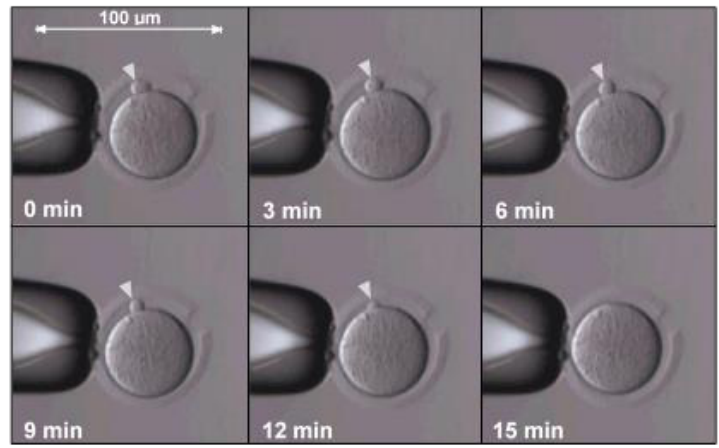
Figure 4. Time-lapse images showing fusion of a cumulus cell into a cytoplast within 15 min. The transferred cumulus cell is indicated by white arrowheads (images captured by C.G. as part of her Masters dissertation at the Reproductive Biology Laboratory, University of